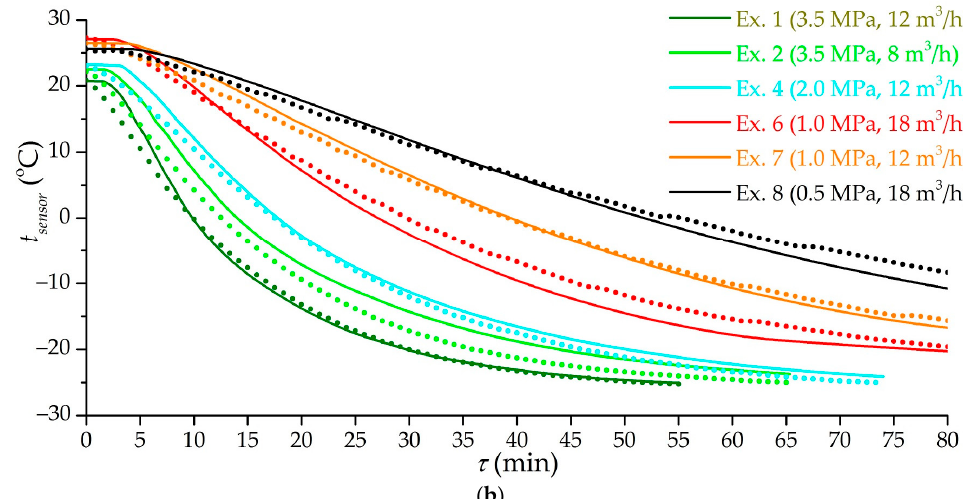
Figure 12. Time dependence of the temperature of sensors 1 ( a ) and 9 ( b ) according to the results of a number of experiments (the number is indicated in the figure) and mathematical modeling. Lines are the results of mathematical modeling. Dots of the same color are experimental values.